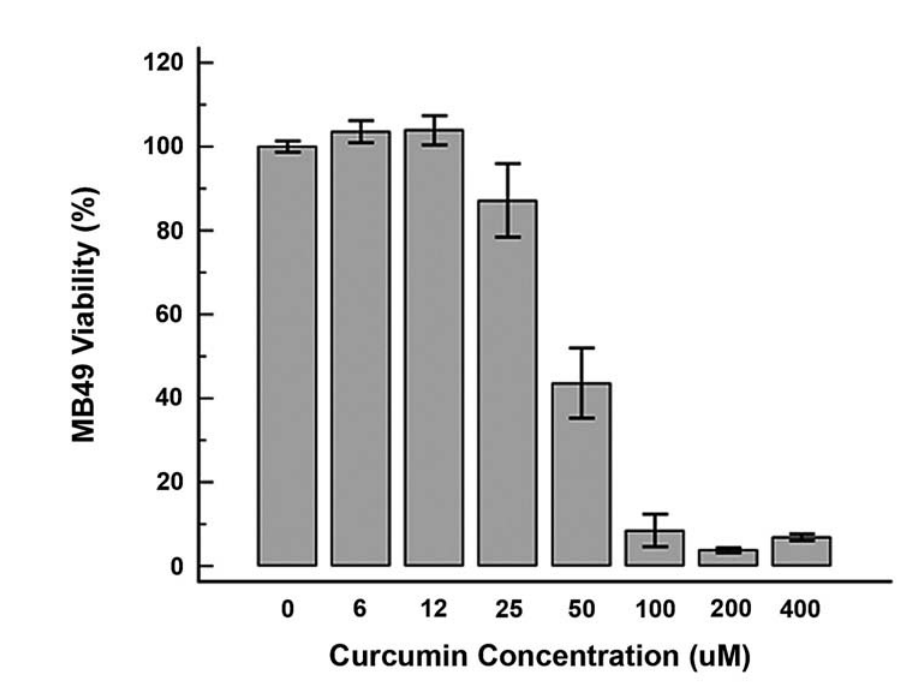
Figure 1 – Columns show the percentage of viable bladder tumor cells when exposed to variable concentrations of curcumin. At 50 mM, there was 55% of apoptosis; in levels higher than 100 mM, less than 10% of tumor cells remained